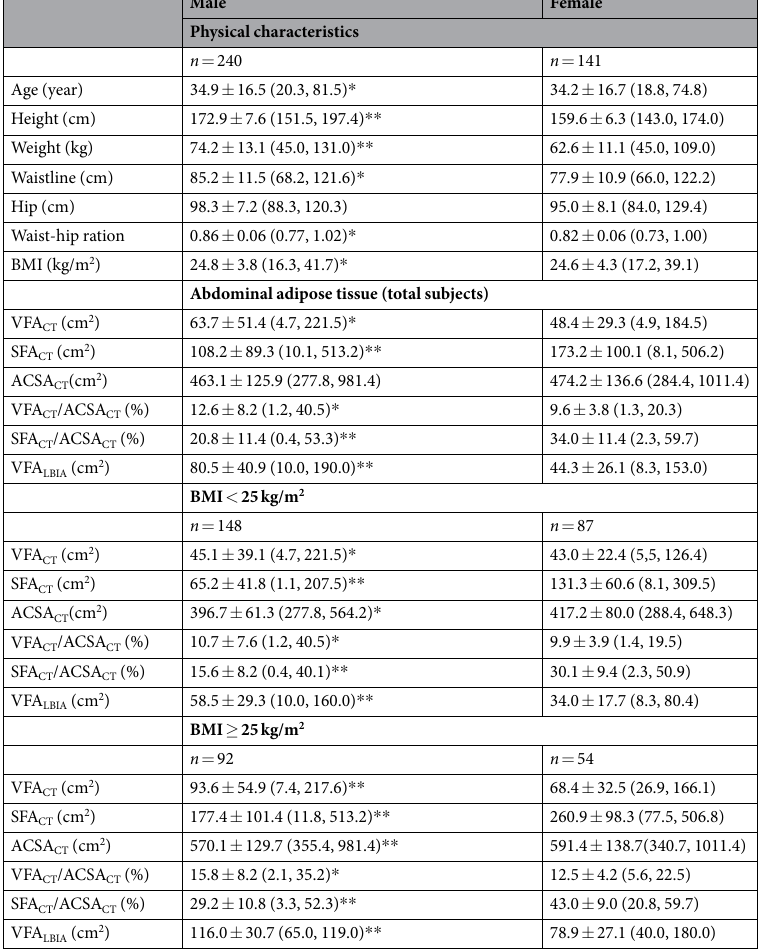
Table 1. Physical characteristic and measured abdominal visceral adipose tissue of the subjects. All values are means ± SD, minimum and maximum in parentheses; * , ** Significantly different from females (one- factor ANOVA): * p < 0.05, ** p < 0.00 1 ACSA: abdominal cross-sectional area, VFA: visceral fat area, SFA: subcutaneous fat area. Lower-case CT indicates results from CT scan; LBIA is a bioelectrical impedance analysis system with four-contact